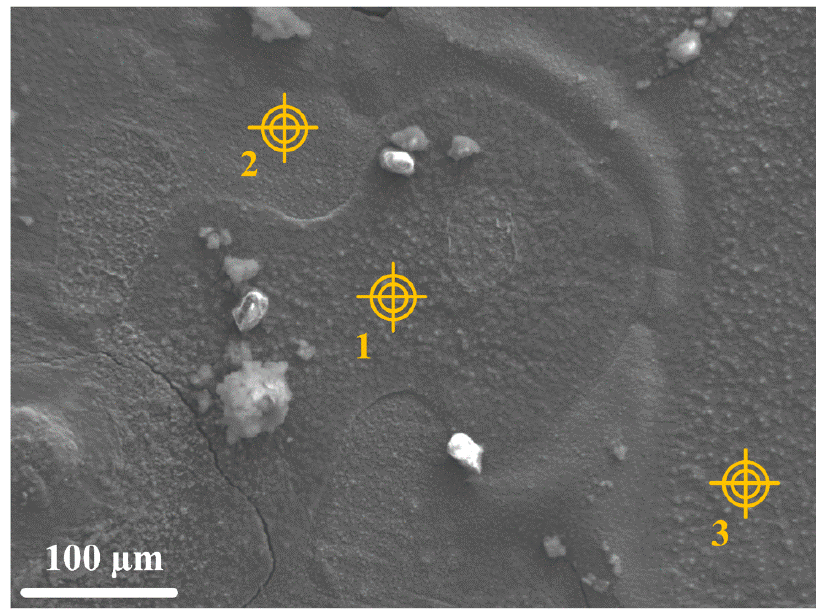
Figure 7. SEM image (secondary electrons) of the surface of the mineral layer present on a carbon steel surface after the experiment. The 3 targets indicate the area analyzed by EDS. Table 4. Proportion (wt.%) of the elements identified during the analysis at spots 1, 2, and 3. Analyzed